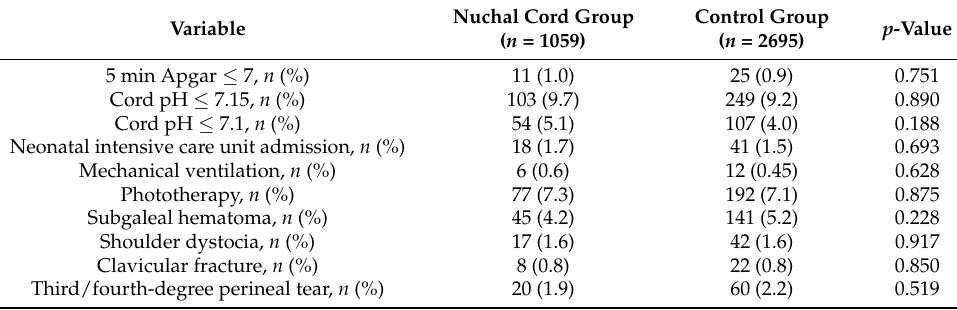
Table 3. Maternal and neonatal outcomes stratified by nuchal cord